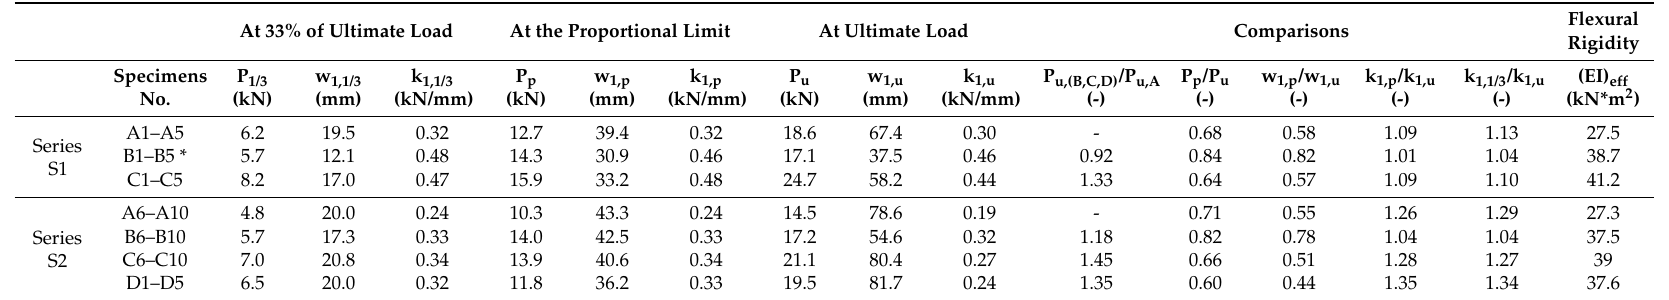
Table 4. Summary of the experimental results of the specimens of both series of tests (i.e., S1 and S2). The loads (P i ) and midspan deflections (w 1,i ) are presented as averaged measured values of all specimens, of the same type and series, and the bending stiffness was calculated as k i = P i /w i . In the last six columns comparisons of the different loads (P i ), the midspan deflections (w 1,i ), the bending stiffnesses, and flexural rigidity are presented. At 33% of Ultimate Load